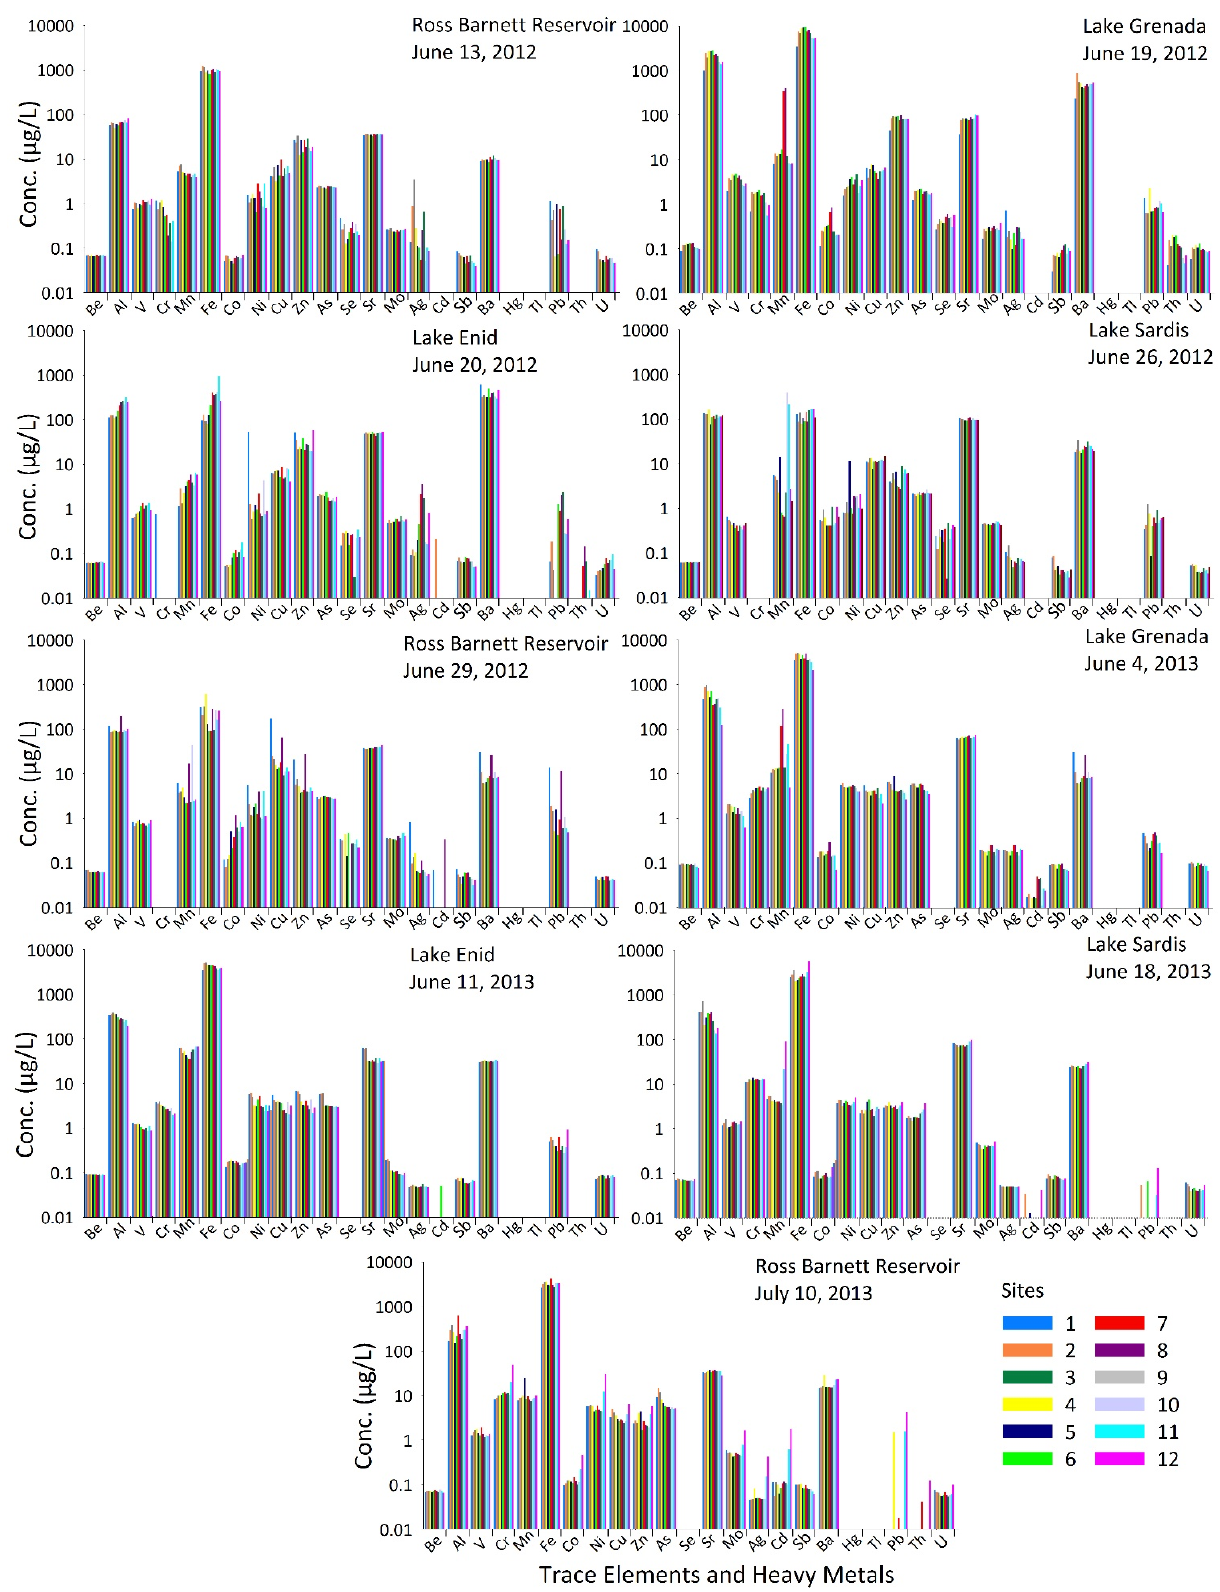
Figure 11. Trace elements and heavy metals at twelve sampling sites in each of the lakes (RB = Ross Barnett Reservoir, LG = Lake Grenada, LE = Lake Enid, and LS = Lake Sardis) with sampling dates